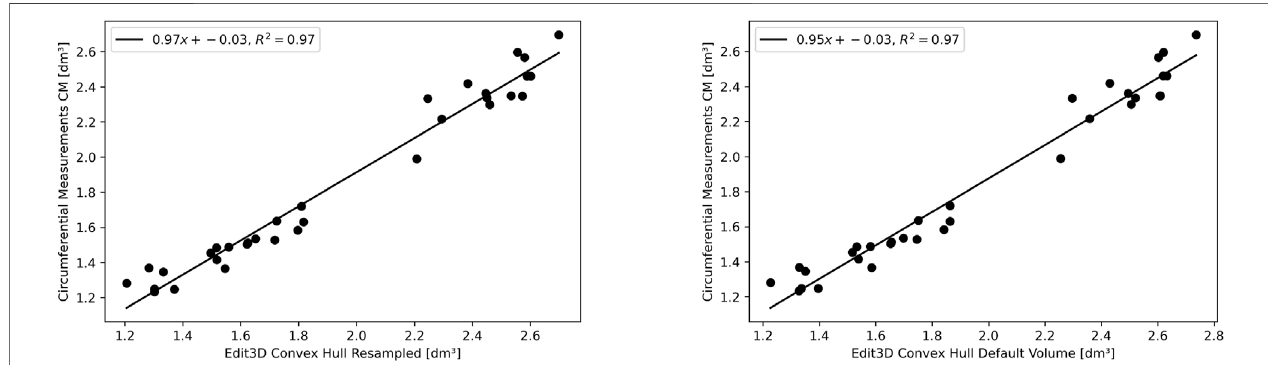
FIGURE 4 | The linear relationship between clinical volume estimation by circumferential measurements CM with Edit 3D convex-hull volume (digital volume from mesh, on the right panel), and with Edit 3D resampled convex-hull (digital volume from point cloud data, on the left